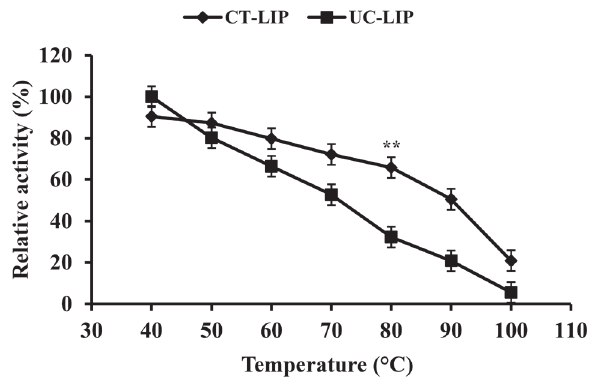
Figure 1. Effect of different temperatures on lipase relative activity. Data were presented with mean±standard deviation (n = 6). Vertical error bars show standard deviation of measured relative activity (**